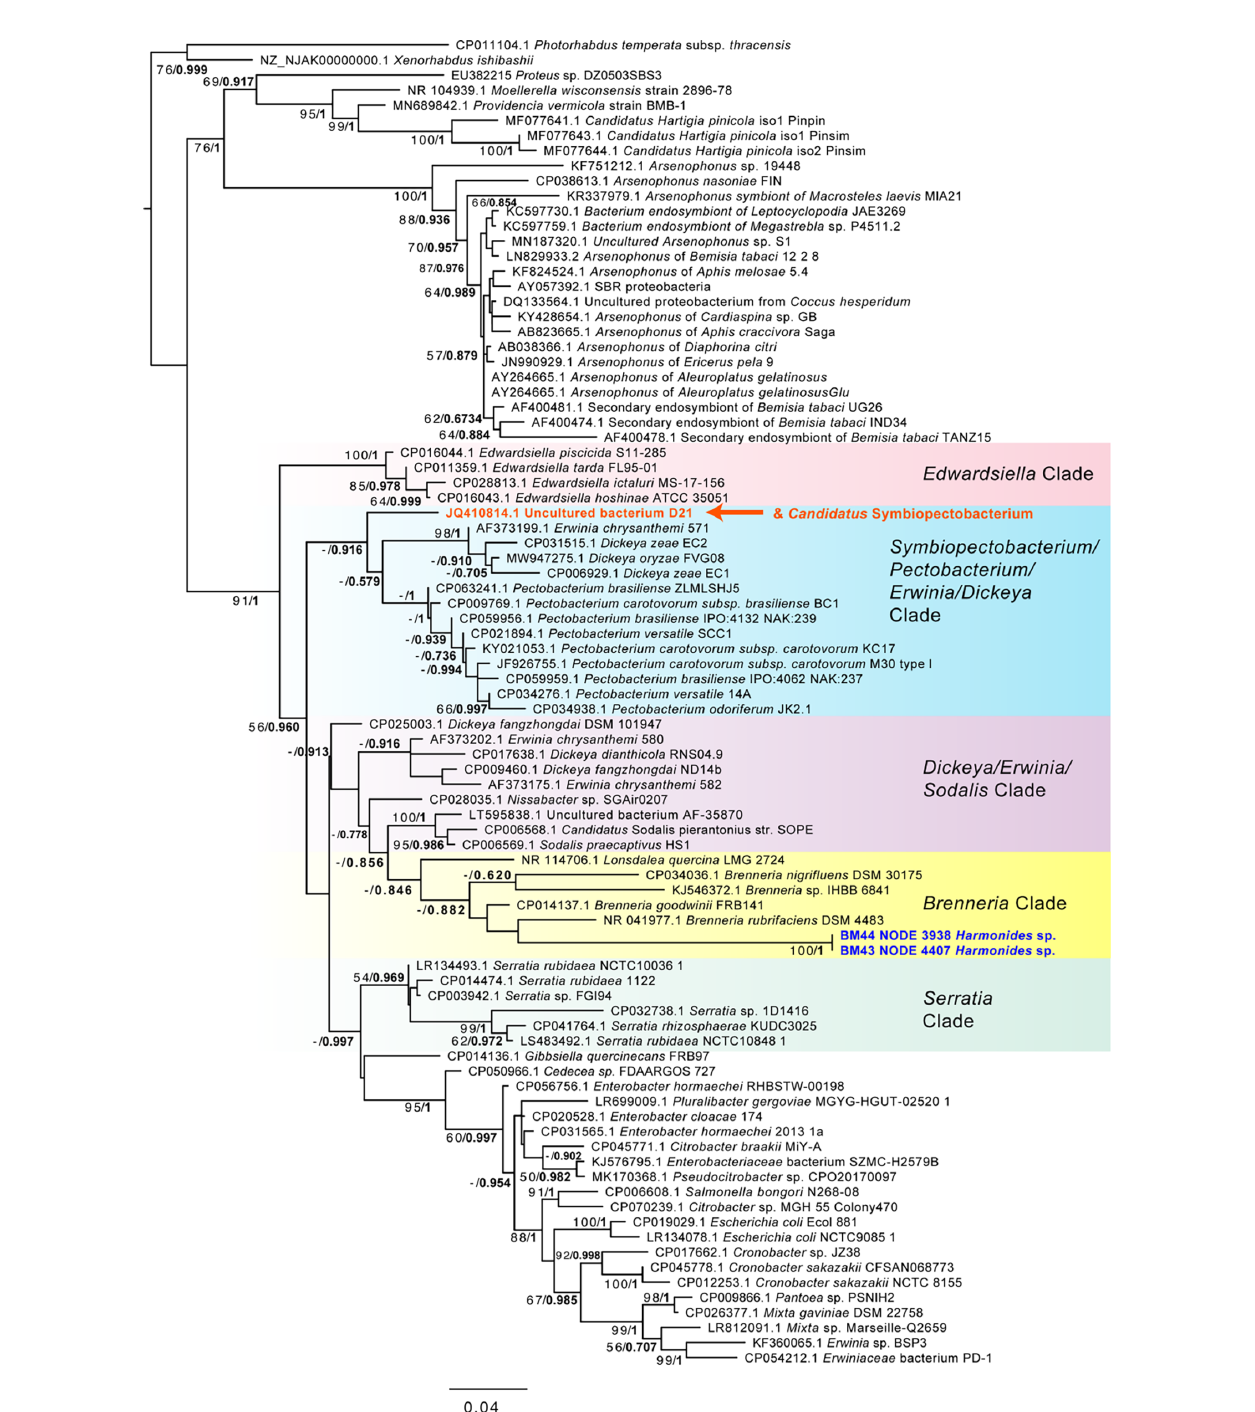
FIGURE 4 | Phylogeny of Enterobacteriales including Pectobacteriaceae and Brenneria -like sequences based on 1,556 aligned positions of the 16S rRNA gene for sequences from GenBank and two membracid samples in this study with highest coverage (bold blue font). Maximum likelihood phylogeny reconstruction was performed in RAxML GTR+Gamma with 100 bootstrap replicates. Supported nodes that were obtained from Bayesian 50% majority rule analysis in MrBayes with GTR+G with 4 rate categories are shown as values on branches as ML bootstrap/Bayesian posterior, with the latter values in bold font. Various Pectobacteriaceae groups are highlighted with color gradient shading. The position of the Candidatus Symbiopectobacterium clade, comprising members with independent secondary endosymbiosis in insects and nematodes, is indicated in orange font.